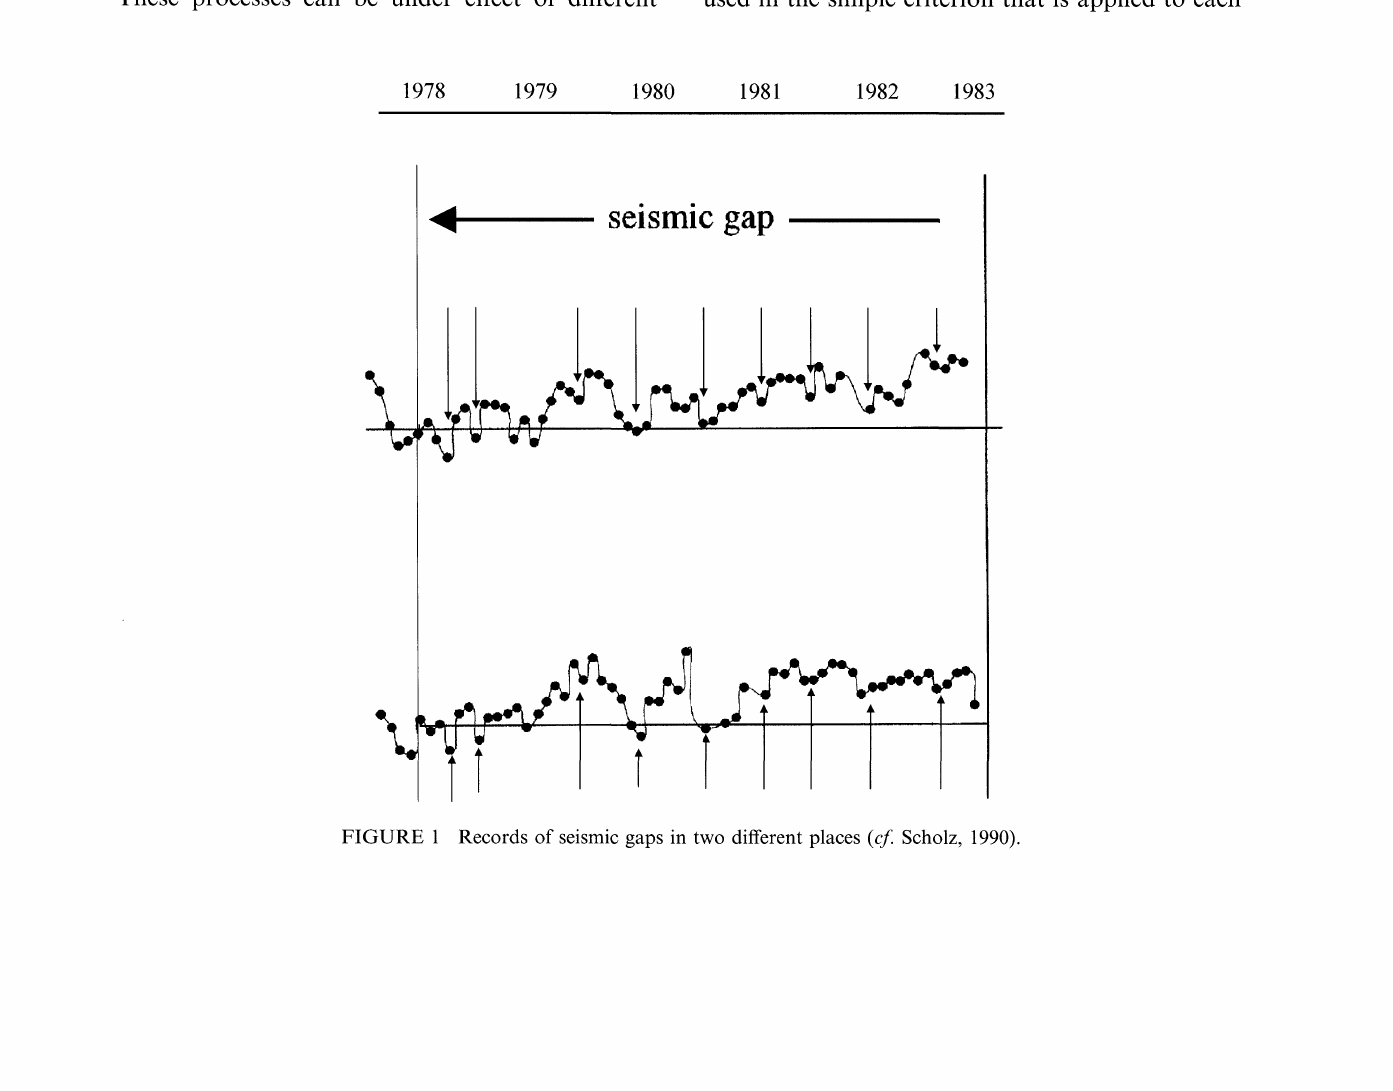
FIGURE Records of seismic gaps in two different places (cf. Scholz,